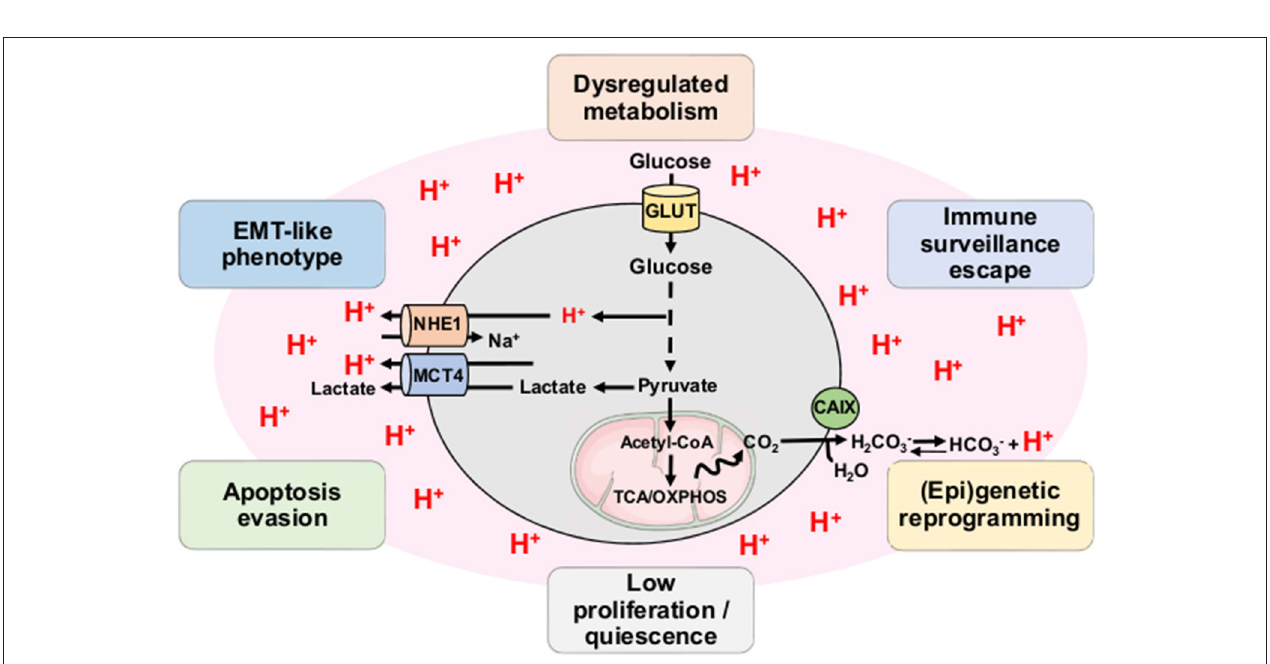
FIGURE 2 | Tumor acidosis influences and maintains CSC-related phenotypic features. Both exacerbated glycolysis and mitochondrial respiration-derived CO 2 hydration in tumor account for production of H + ions and subsequent environment acidification. Tumor acidosis contributes to the emergence and/or maintenance of stem-like phenotypic features such as dysregulated metabolism, immune surveillance escape, (epi)genetic reprogramming, low proliferation, apoptosis evasion, and EMT-like phenotype. CAIX, carbonic anhydrase IX; MCT4, monocarboxylate transporter 4; NHE1, sodium-hydrogen antiporter 1; OXPHOS, oxidative phosphorylation; TCA, tricarboxylic acid